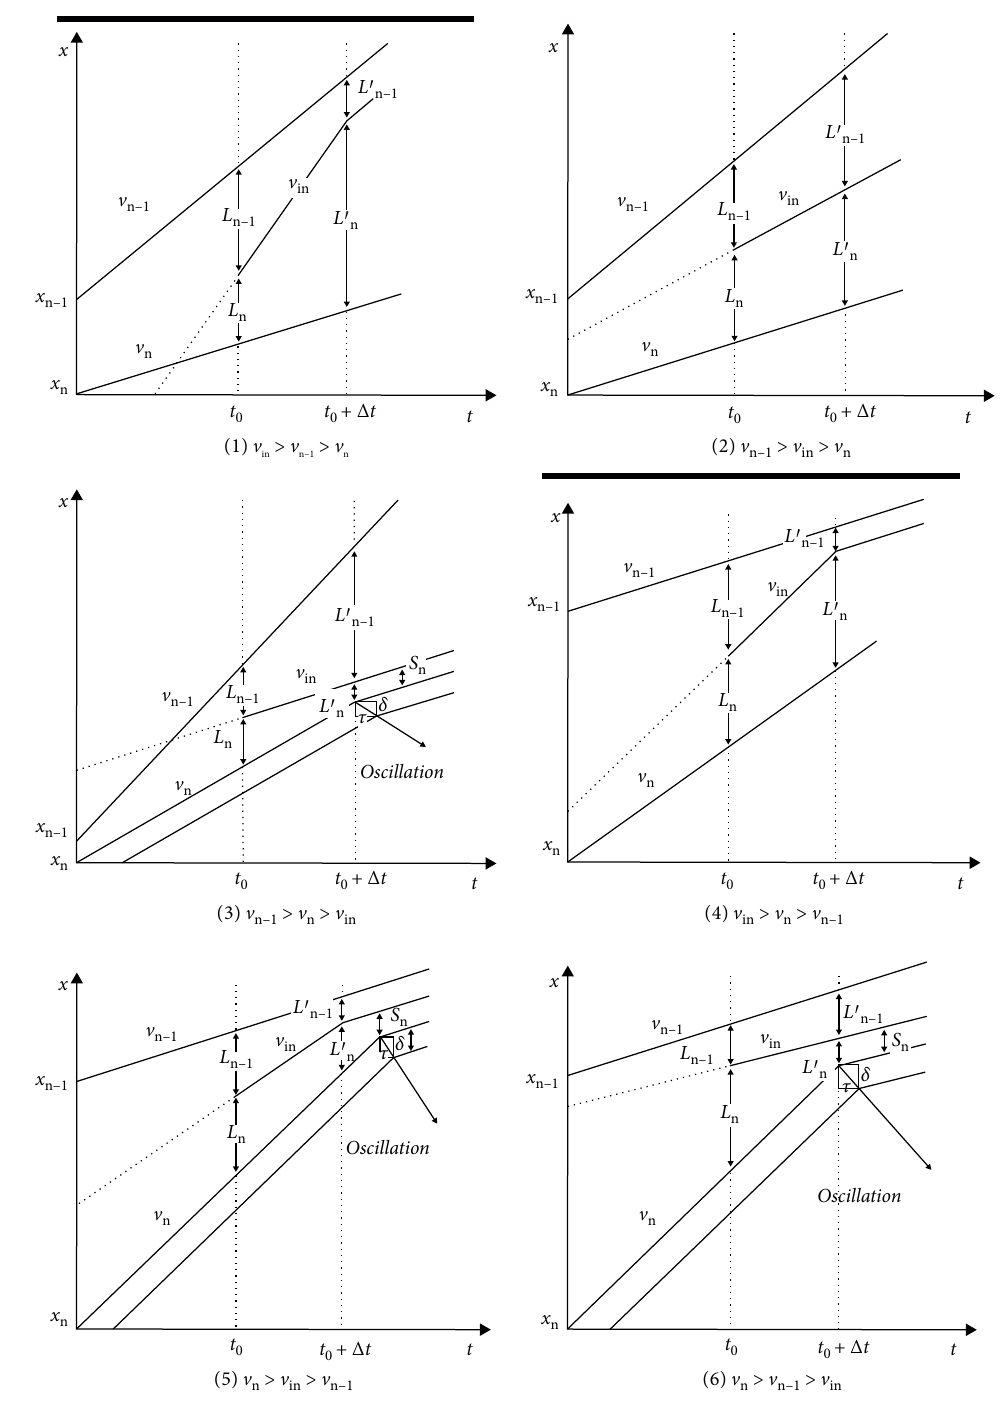
Figure 4: Schematic diagram of the Merging process in different